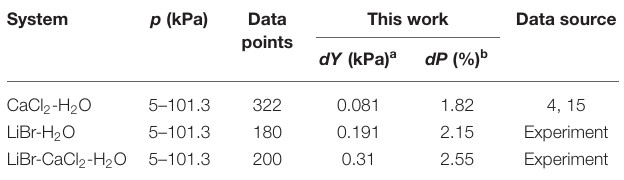
TABLE 8 | Correlation results of VLE data.